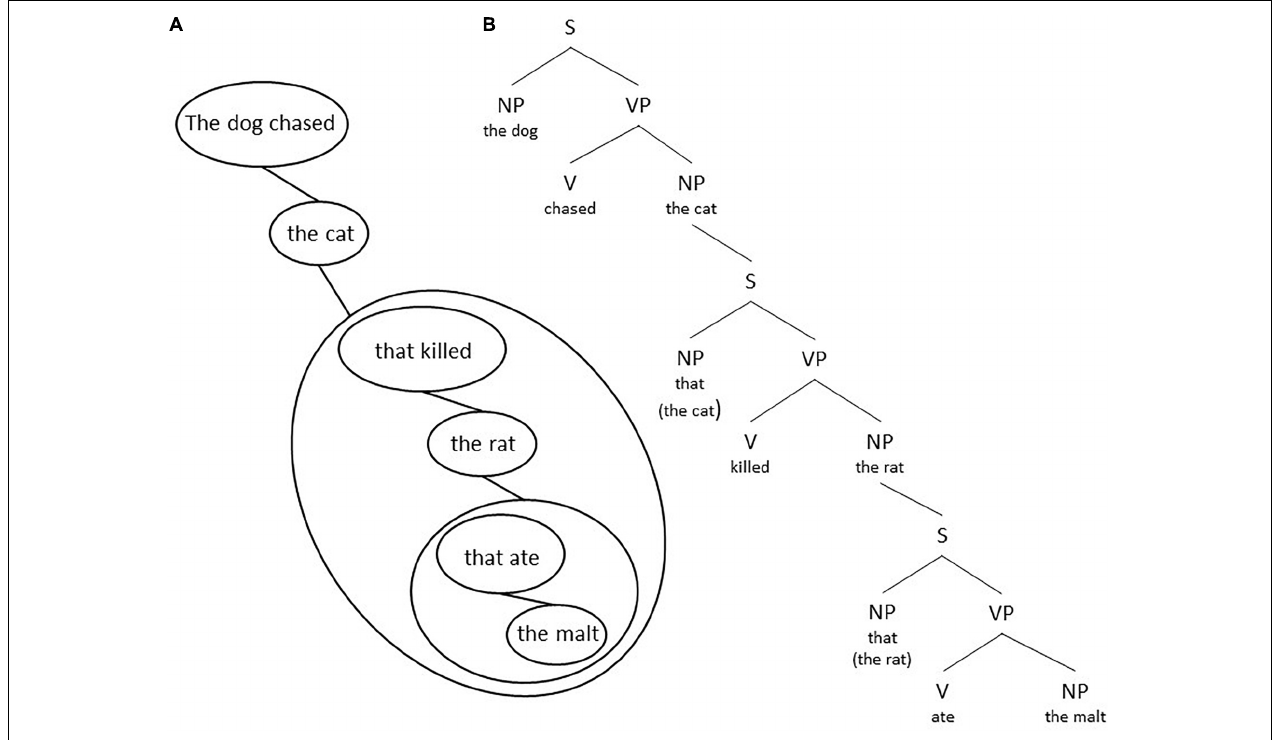
FIGURE 8 | A structural representation of utterance (6b) according to Focus: (A) its chunking structure and (B) a related grammar